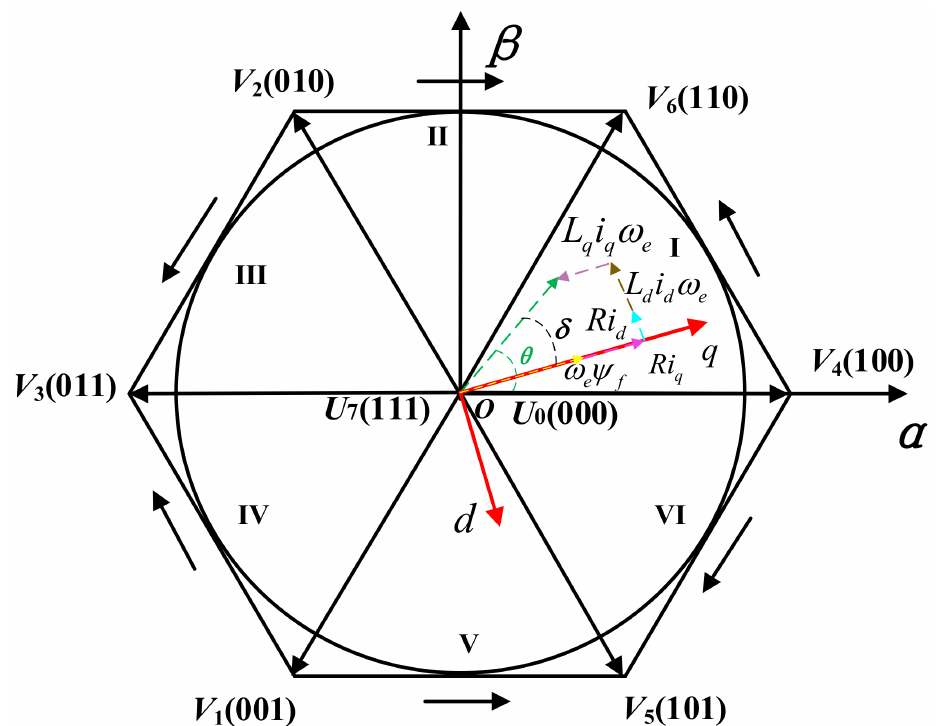
Figure 2. Principle of the conventional